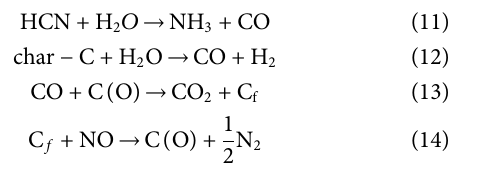
Frontiers in Energy Research |